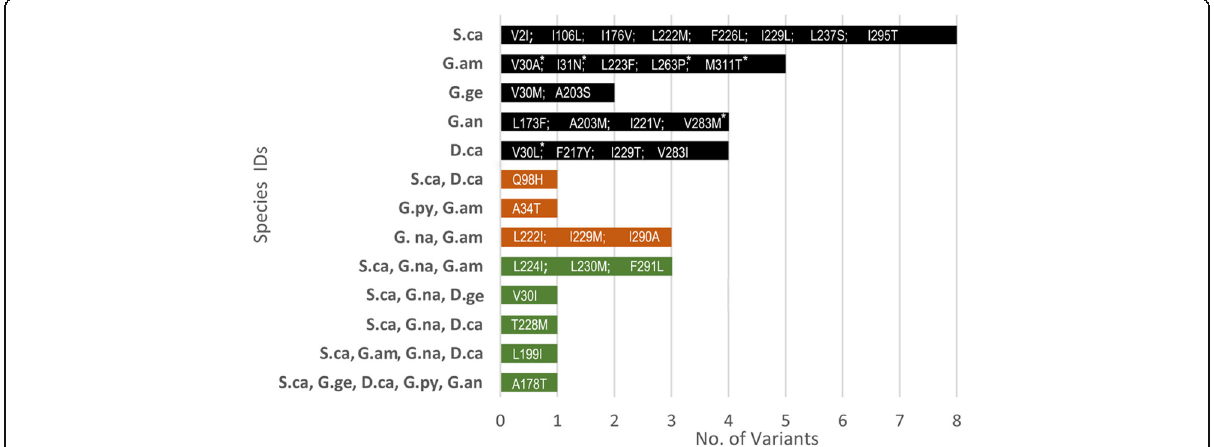
Fig. 2 Cyt b amino acid variants within and between species. G & S indicates Gerbillus & Sekeetamys ; na, ca, am, an, cam, ge, & py, represent nanus , calurus , amoenus , andersoni , campestris , gerbillus , & pyramidum , respectively. Asterisk (*) is used to indicate variants which are geographically